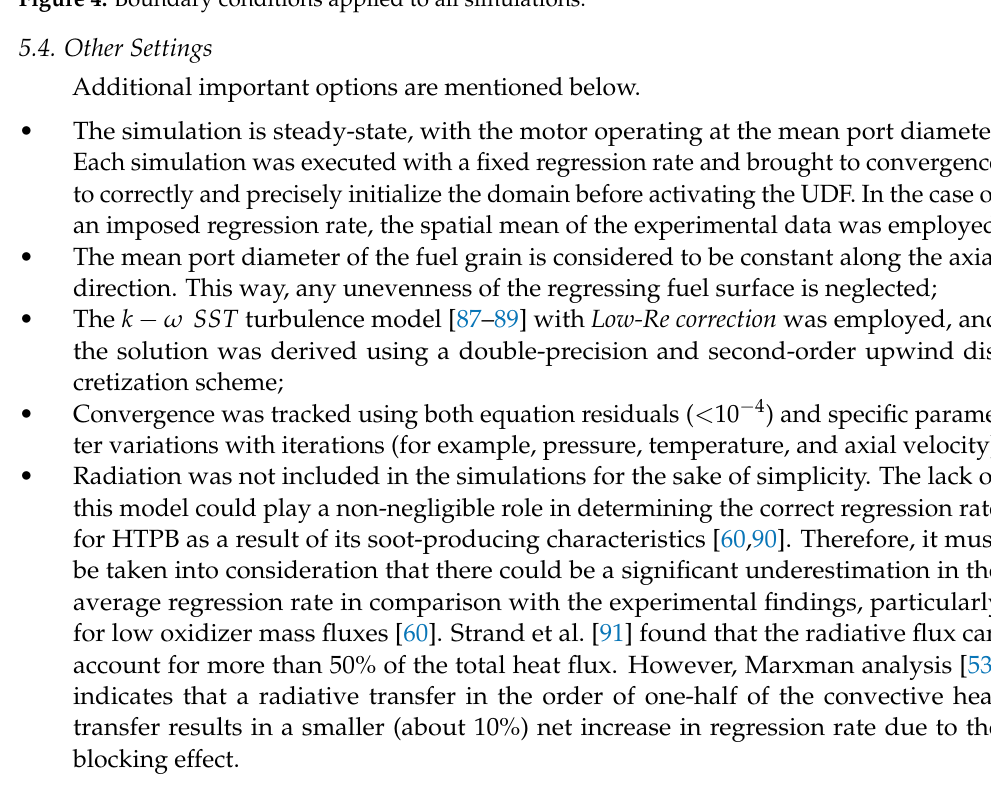
Figure 4. Boundary conditions applied to all simulations.